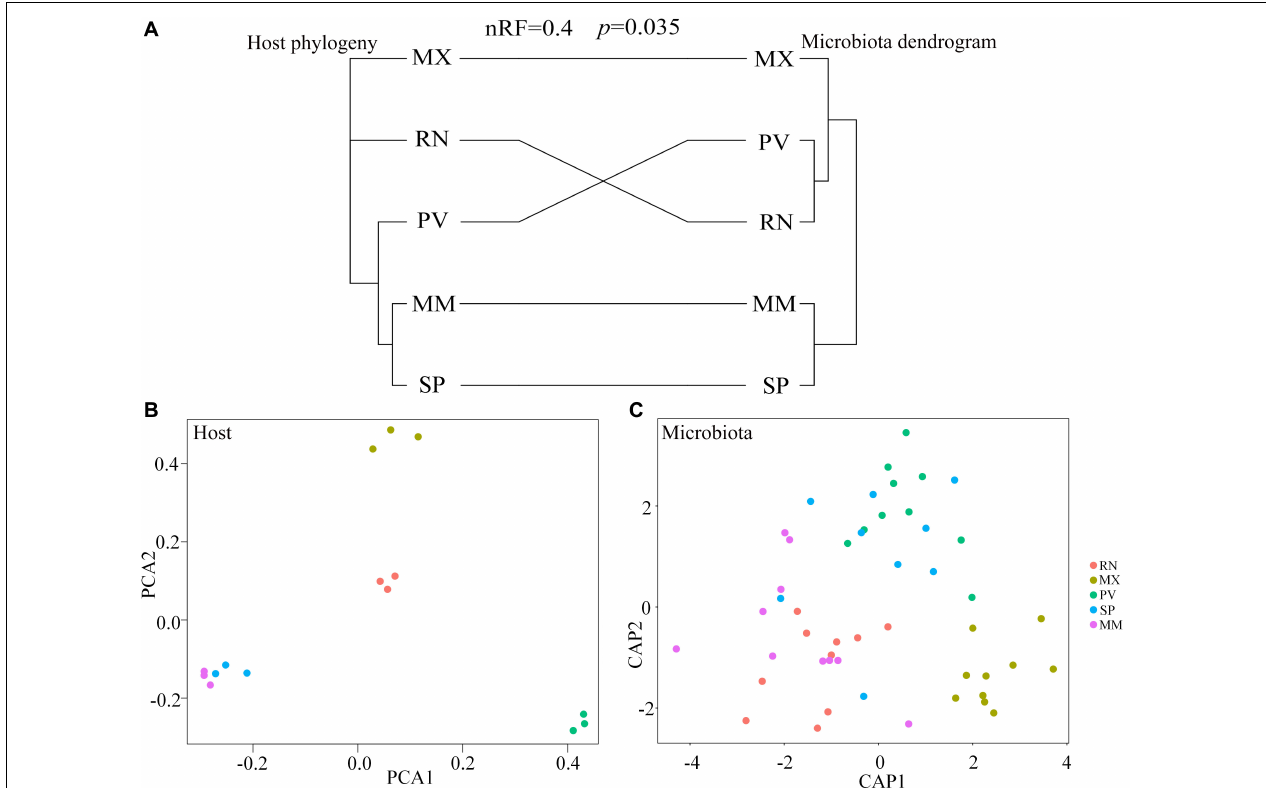
FIGURE 4 | Phylosymbiosis occurred in ring-necked pheasant (RN), manchurian pheasant (MX), phasianus versicolor (PV), Shenhong pheasant (SP), and melanistic mutant pheasant (MM). (A) Comparing host phylogeny to dendrogram of corresponding microbial communities for five pheasant lines. Host phylogeny constructed using filtered SNPs of pheasant whole genome. Microbial dendrogram were constructed using beta diversity. Congruence was measured using normalized Robinson–Foulds (nRF) scores. (B) Principal component analysis (PCA) based on the host genome. (C) Canonical analysis of principal coordinates (CAP) based on the weighted UniFrac metrics of gut microbiota to reveal a separation among